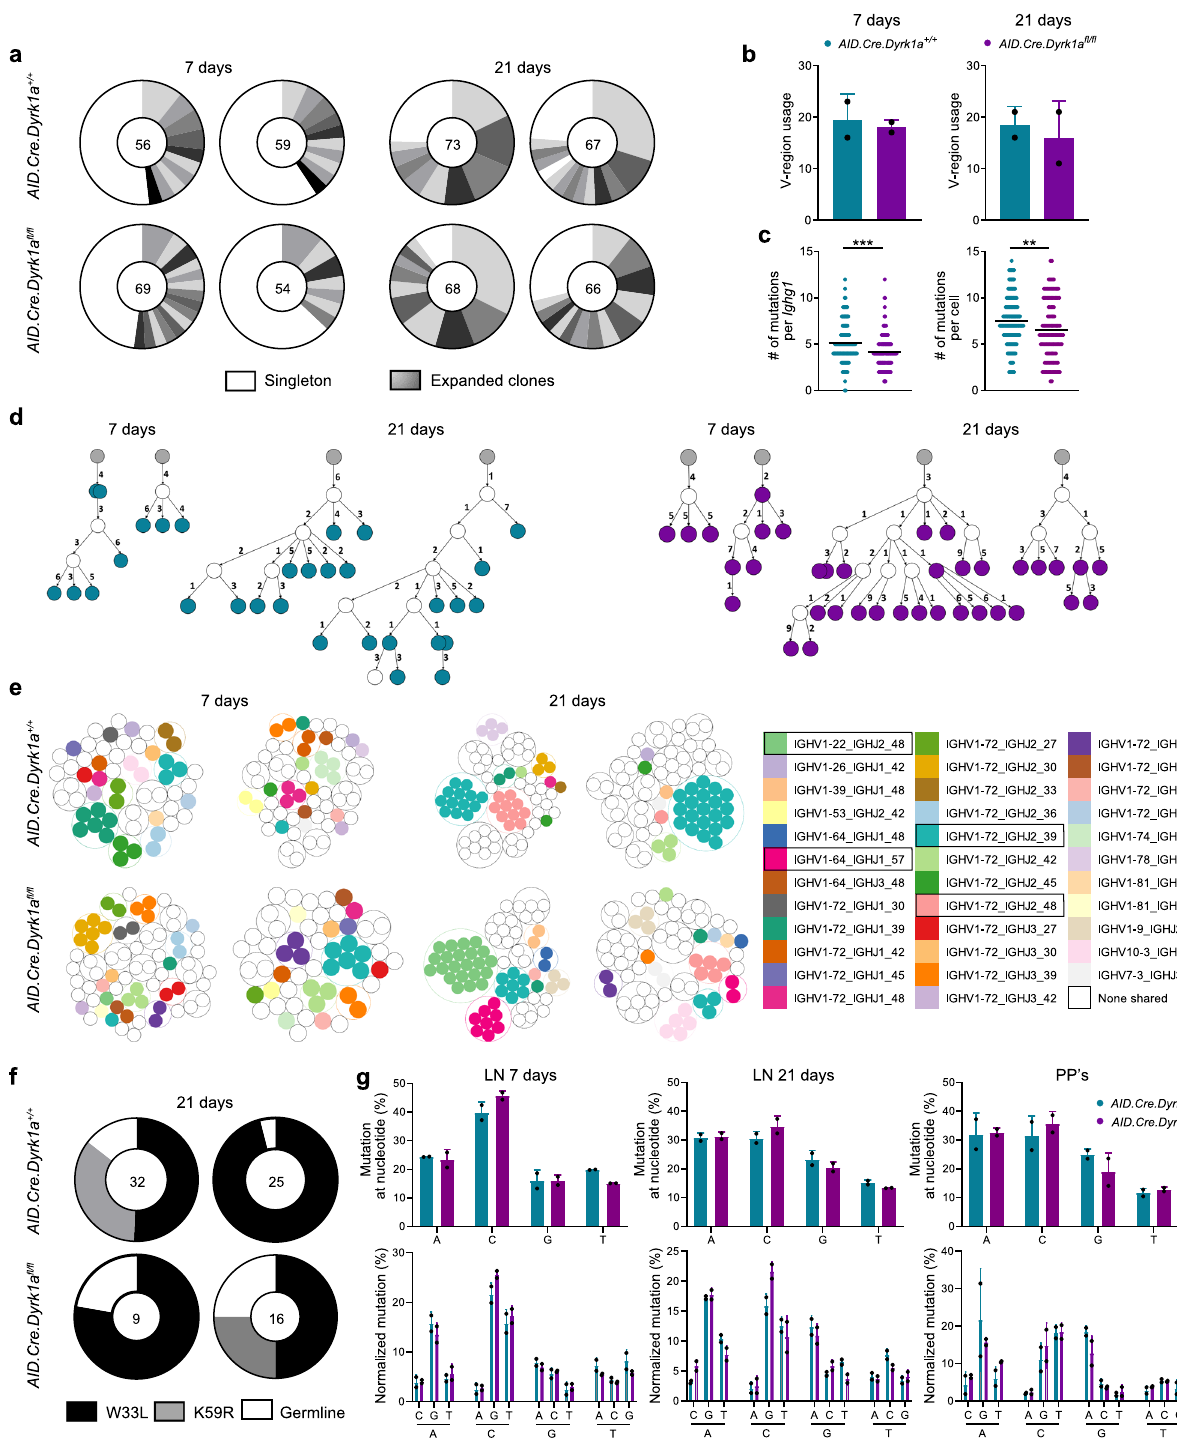
Fig. 5 | Antigen-speci fi c clonal expansion but not SHM depends on DYRK1A functions. a Pie charts showing the clonal distribution of Ighg1 sequences in GC B cells derived from one LN of a single mouse, 7 or 21 days after NP-KLH immuni- zation. Each segment represents a unique clone. The total number of analyzed sequences is indicated in the center of each chart ( n =2; two independent experi- ments). b The number of different V-regions detected in Ighg1 sequences as in ( a ). Bars and error bars represent the mean with SD ( n =2; two independent experi- ments). c The number of SHMs per analyzed sequence as in ( a ). ( n =113 – 135; two independent experiments, two-tailed Student ’ s t test); ** P ≤ 0.01, *** P ≤ 0.001. d Phylogenetic trees of representative individualclones. Gray circles represent the hypothetical germline con fi guration. White circles represent hypothetical ances- tors. Numbers appearing next to the arrows represent the number of distinct